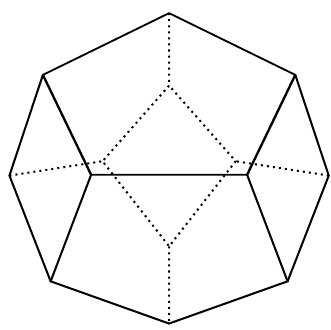
Figure 4 . Cluster polytope of the cluster algebra of Gr(2 ;